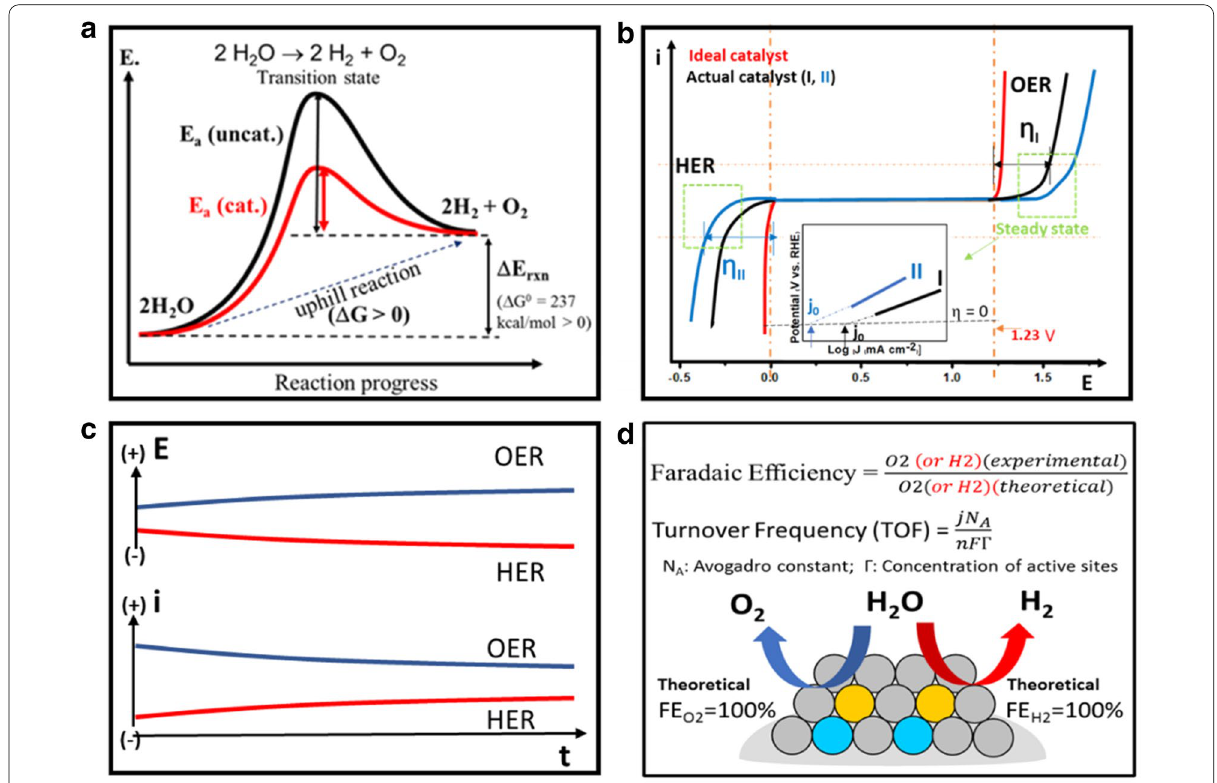
Fig. 2 a Schematic illustration of the catalyst’s role in lowering the activation energy barrier; b – d schematic illustrations of the performance evaluation parameters of electrocatalyst, including, b activity in terms of overpotential, Tafel slope, and exchange current density, c stability in terms of current‑ and potential‑time curves, and d efficiency in terms of faradaic efficiency and turnover